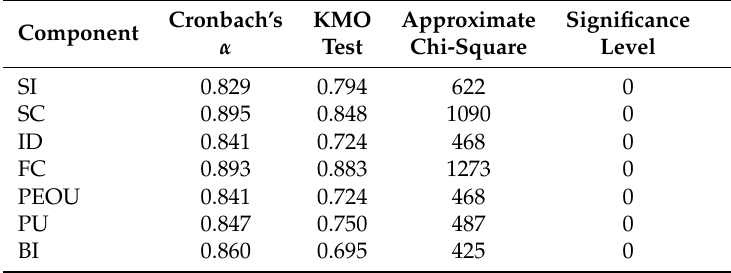
Table 1. Test results of the reliability and validity